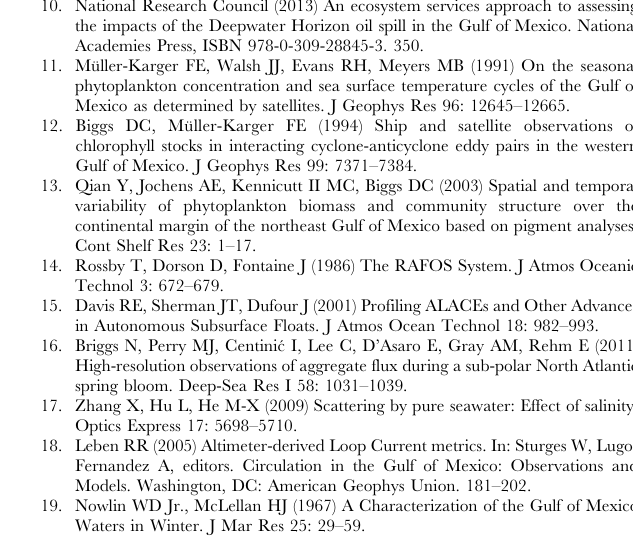
Figure S1 Picture of APEX float being deployed in the Gulf of Mexico. The antenna and pumped CTD are located at the top of the float, whereas the optical sensors are located near the bottom of the instrument (Photo Credit: CANEK group, CICESE). Figure S2 Contour plots of bio-optical profiles over the entire depth range the float transited. (A) Chl, (B) b bp , and